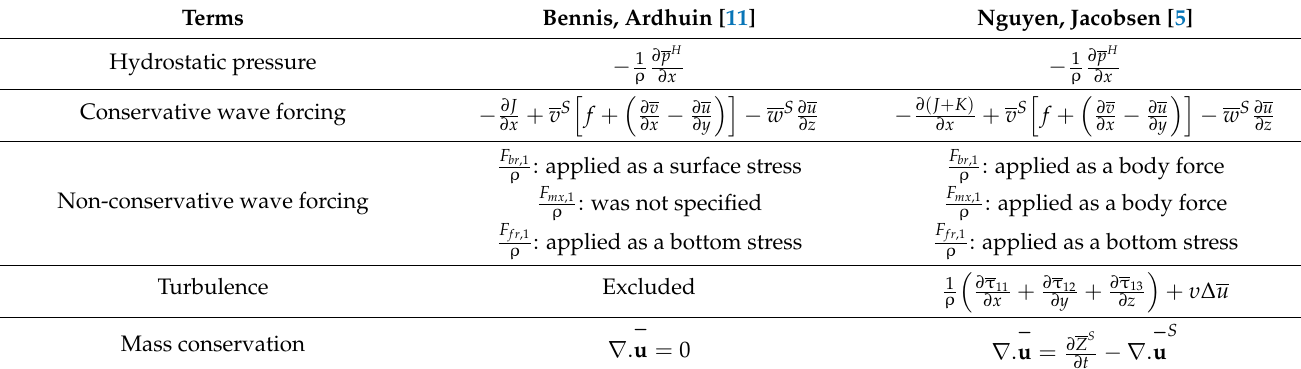
F br ,1 ρ : applied as a body force F mx ,1 ρ : applied as a body force F fr ,1 ρ : applied as a bottom